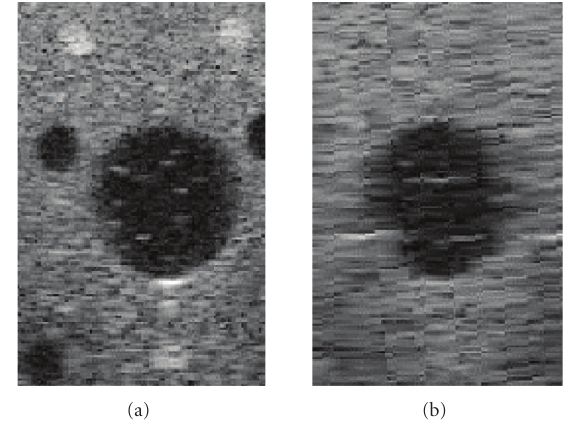
Figure 2: Nonuniform resolution feature in bilinear reconstruc- tion volume from freehand 2D slices: (a) high resolution in cross- sectional view, (b) low resolution in sagittal view.